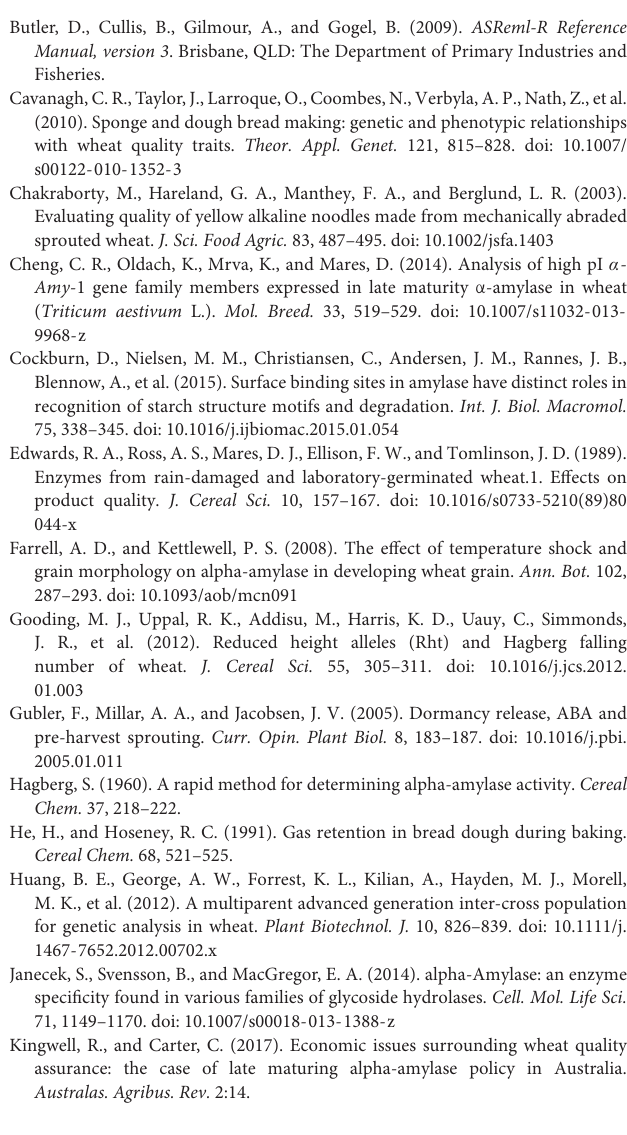
FIGURE S1 | Boxplots of raw values for bread quality traits from commercial varieties, as well as tall and semi-dwarf MAGIC RILs grown at Yanco, Narrabri, and Wongan Hills. Horizontal lines indicate the median and interquartile ranges of the observed